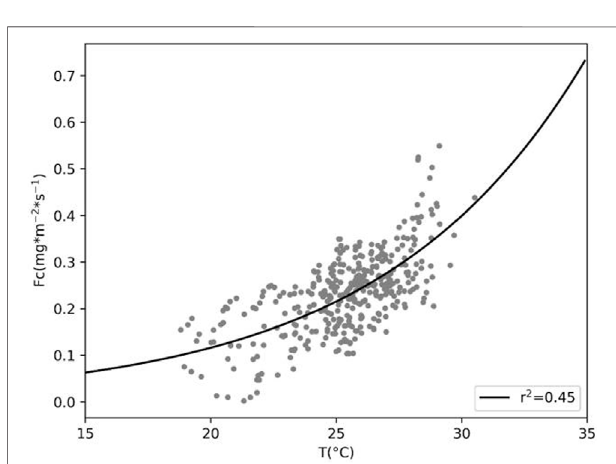
FIGURE 1 | Fitting effect of night NEE (Fc) and temperature (Ta) with the Vant ’ s Hoff breath equation between August 3 and October 4, 2018. The relationship between night NEE and T is signi fi cant for examining ( R 2 = 0.45; p < 0.05).